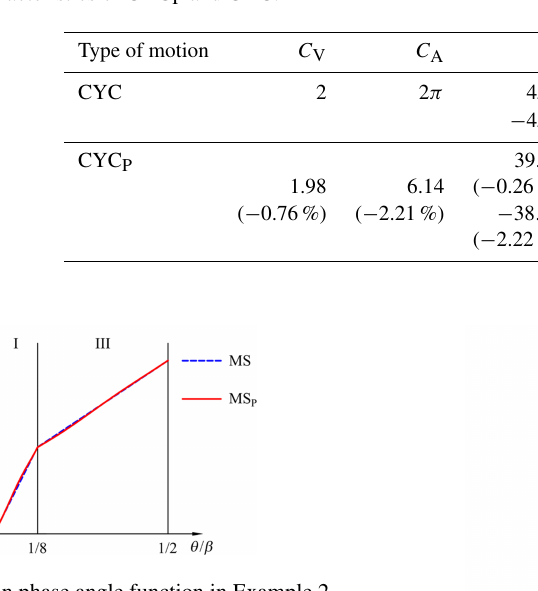
Table 2. Motion characteristics of CYC P and CYC.